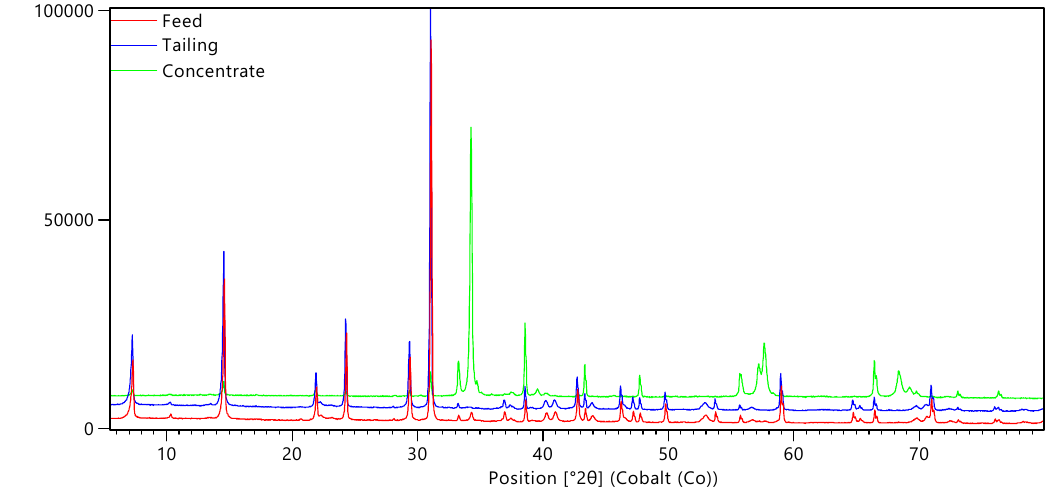
Figure 2. Characteristic XRD scans of the ore blend used as feed for the flotation cell, tailings and concentrates. XRD scans of tailings and concentrates are here vertically shifted by 3000 and 6000 counts for clarity.